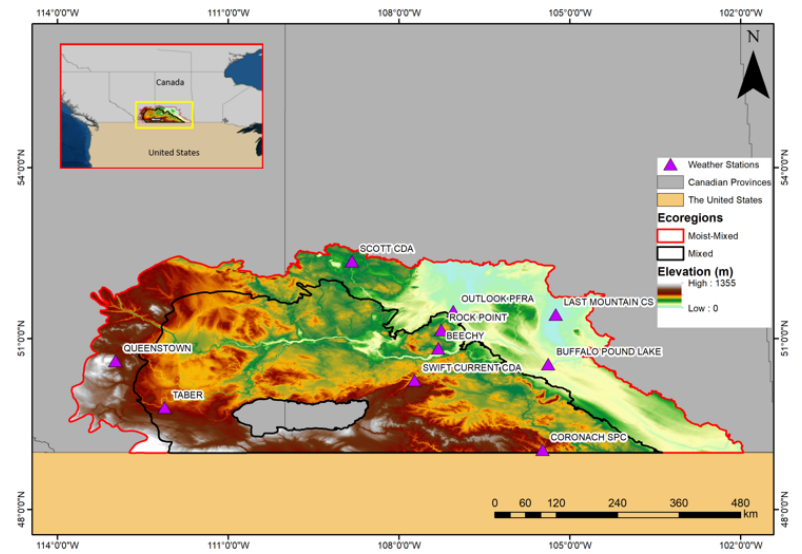
Figure 1. Study area, including the Mixed and the Moist-Mixed Ecoregions, and the weather stations and elevation (m)—(USGS/SRTMGL1_003 [40]).